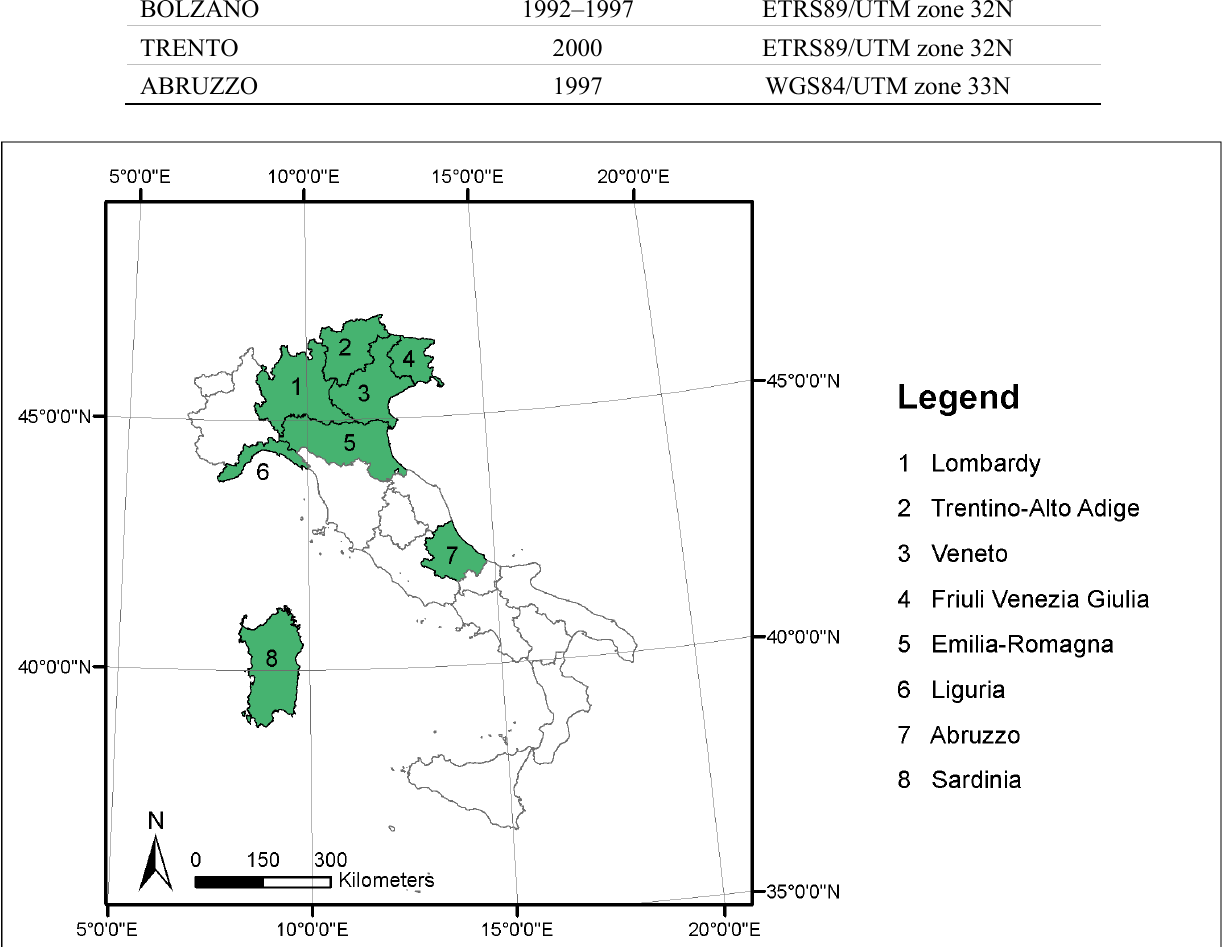
Figure 2. Italian land coverage datasets currently available for the